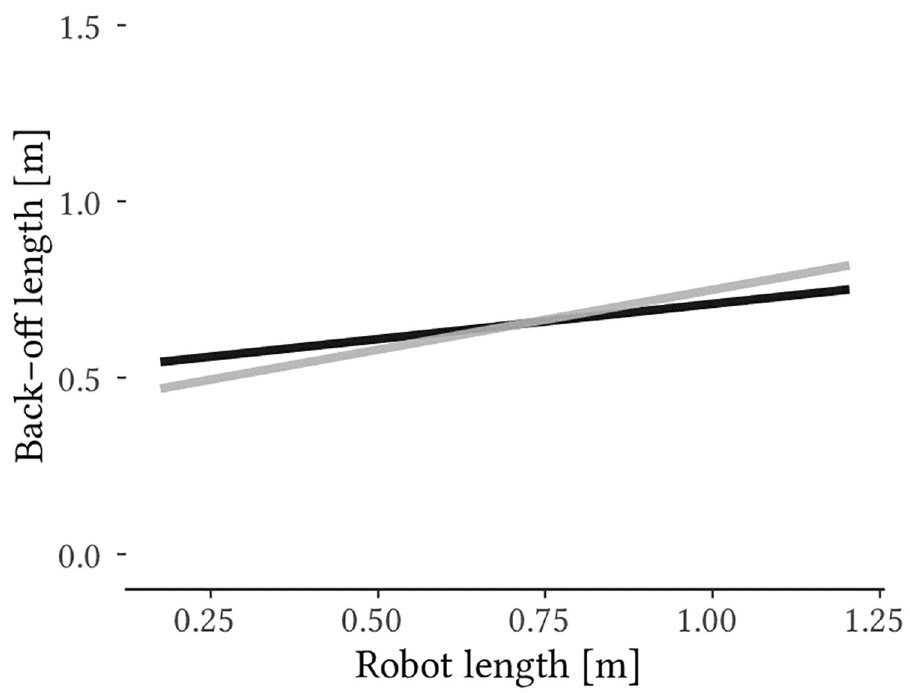
Fig 3. Predicted necessary back-off length depending on robot size and viewpoint. The black line represents the linear equation for the frontal view, the gray line represents the linear equation for the lateral view. The number of measurements used to create the model is N = 500.